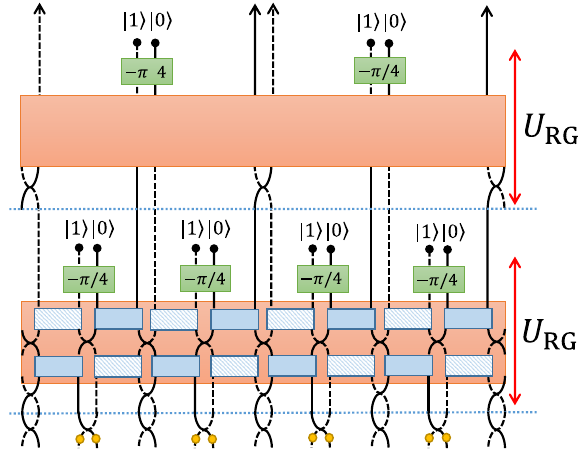
FIG. 1. MERA quantum circuit preparing an approximate ground state of the one-dimensional hopping Hamiltonian (1), using the notation of Ref. [29]. As discussed in Sec. III, the tensor network consists of an initial “ preprocessing ” step followed by repeated layers of “ renormalization-group ” circuits. Each re- peated layer consists of a finite depth circuit followed by projection of half the d.o.f. onto a product state. In more detail, we first apply phase gates (yellow circles) and swapping sub- lattices in order to let the following gates act either on the even or the odd sublattice. The bulk of the MERA corresponds to two independent wavelet transforms, one for h (even sublattice) and s one for g (odd sublattice). Each step of the two wavelet s transforms gives rise to a layer (red boxes) of two parallel quantum circuits of depth K þ L , consisting of 2 × 2 unitary gates (solid or hatched blue boxes). At the end of each layer, we apply second quantized Hadamard unitaries (green boxes) that couple both sublattices, and we occupy the negative-energy modes. The figure illustrates the case of K ¼ L ¼ 1 and L ¼ 2 layers. As we increase K , L , and the number of layers L , we systematically obtain better and better approximations to the ground state (see Sec.